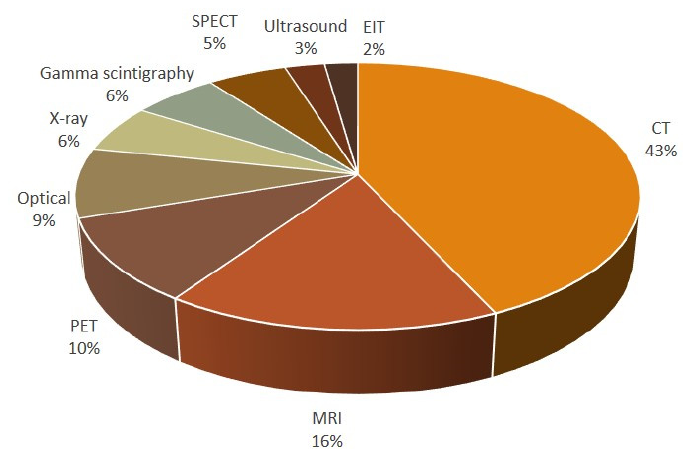
Figure 4. Imaging modalities used to monitor lung injury in vivo.